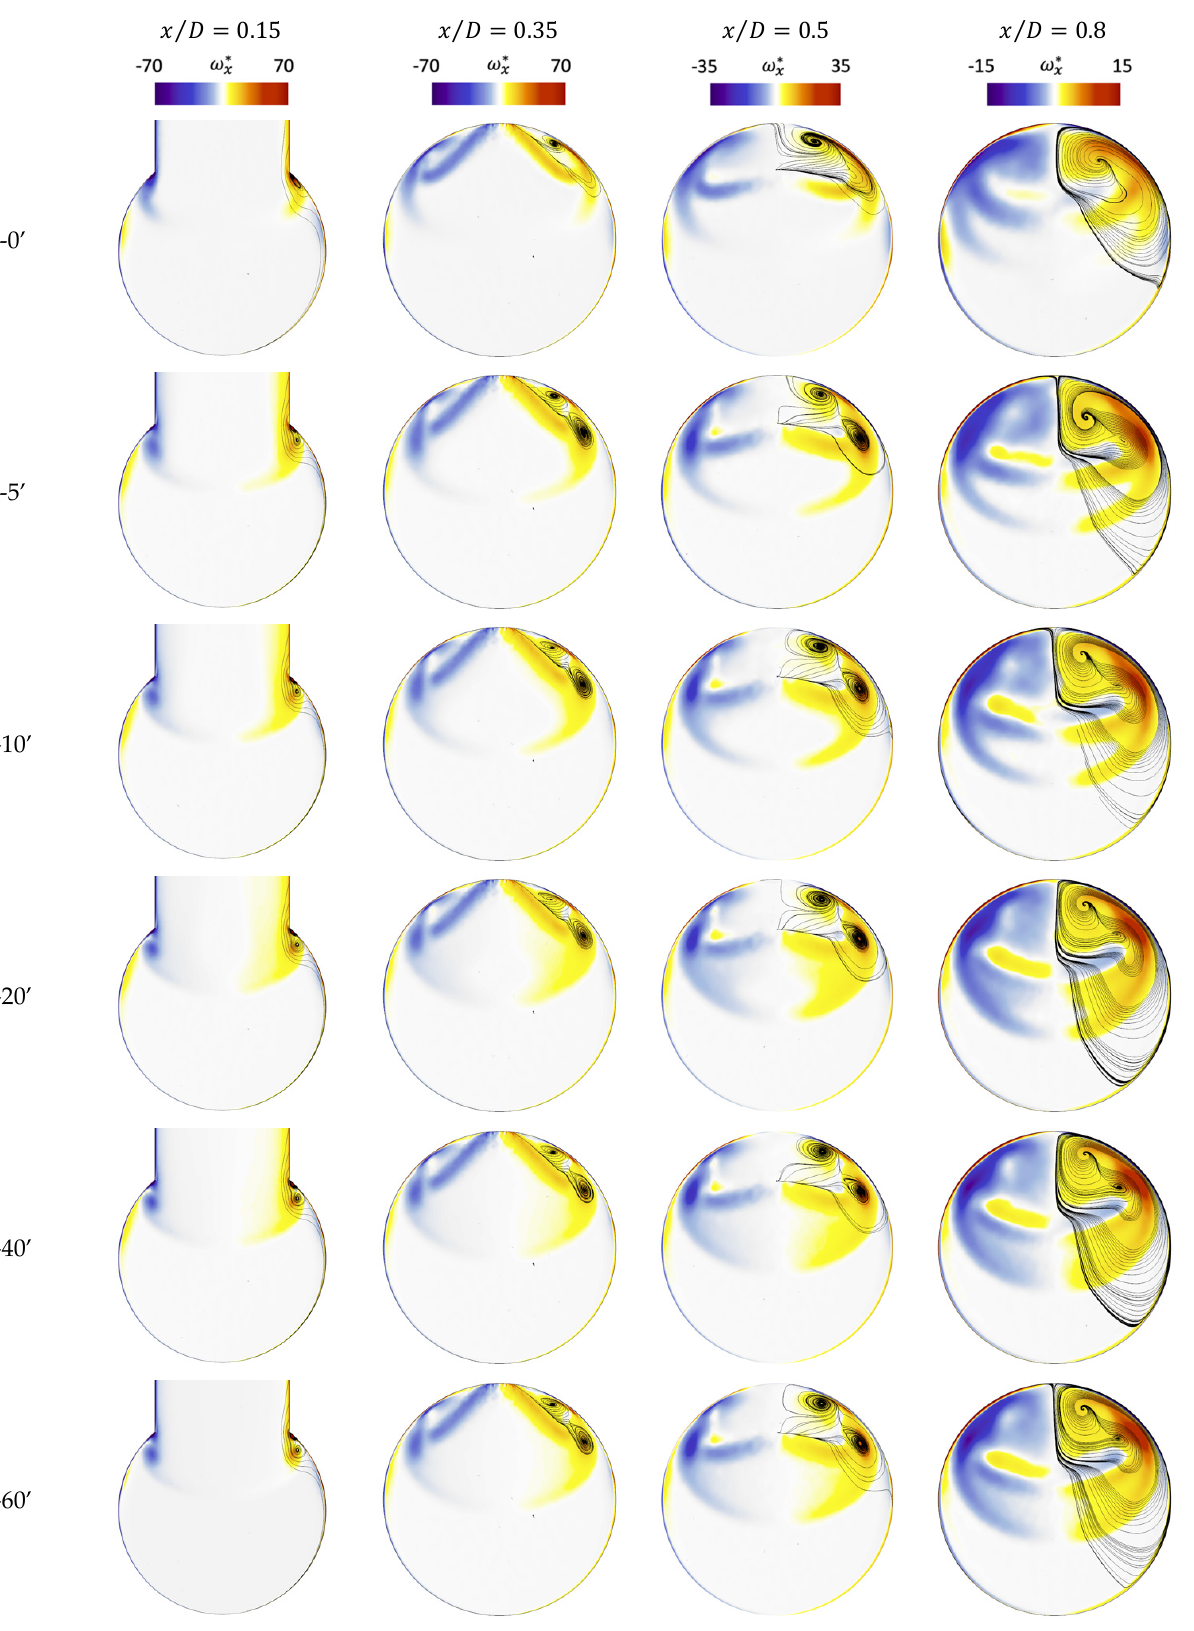
Figure 14. Contour plots of ω ∗ x with in-plane mean velocity streamlines (black lines) on different cross-sections for cases with uniformly distributed BCs—Jet entrance and recirculation region.